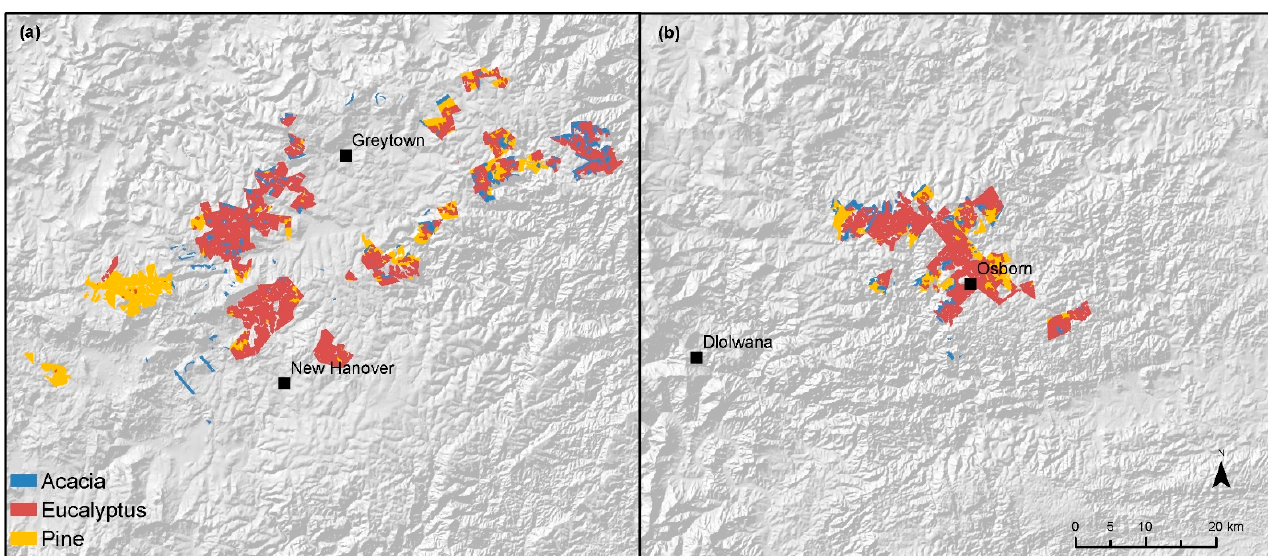
Figure 4. In situ data of genus distribution in the southwestern part of Study Area 2 ( a ) and the northeastern part of Study Area 2 ( b